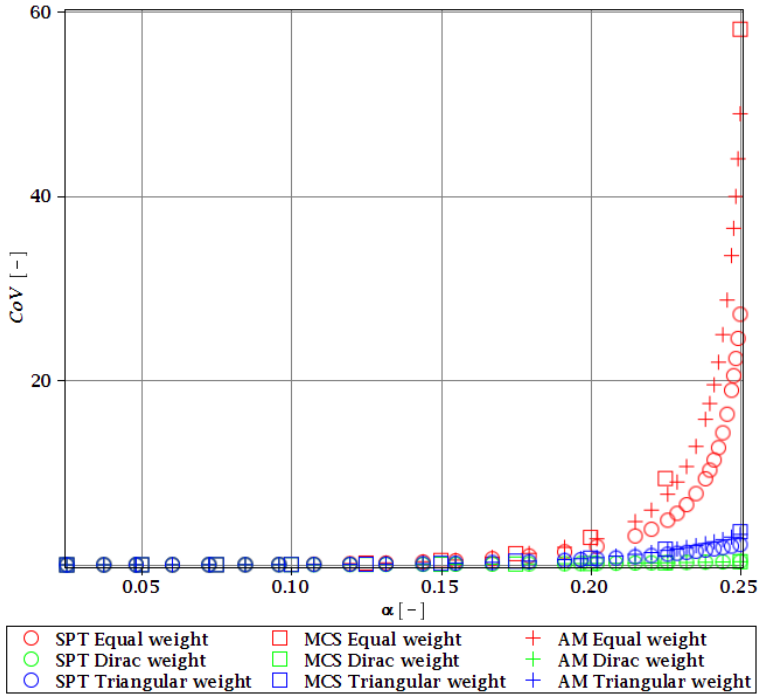
Figure 9. CoV of the critical load for different types of weights.